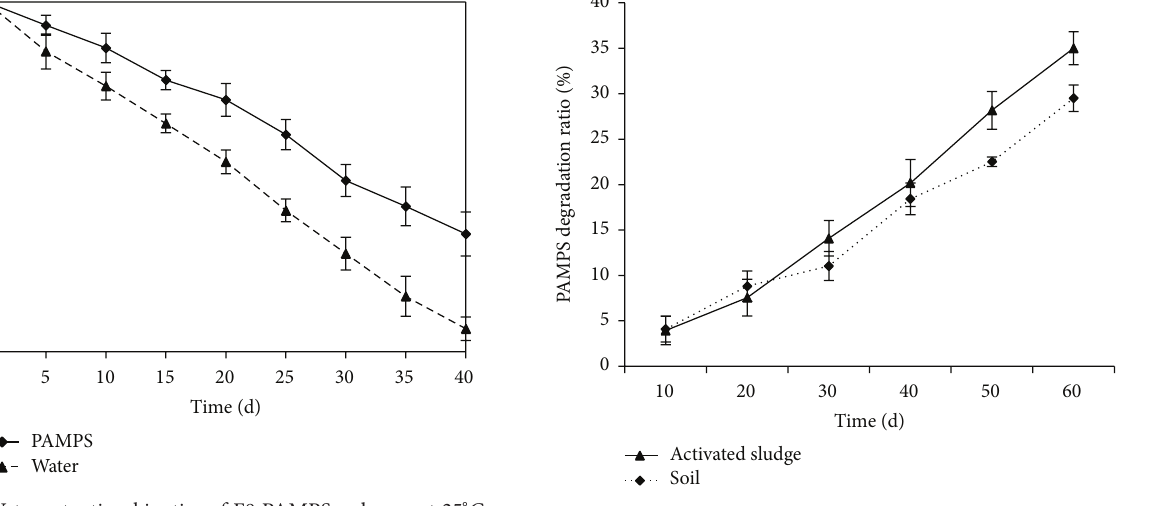
Figure 6: F8 PAMPS polymer disintegration ratio versus time histories in soil and activated sludge. Error bars represent ± S.E. For additional explanations, see Figure